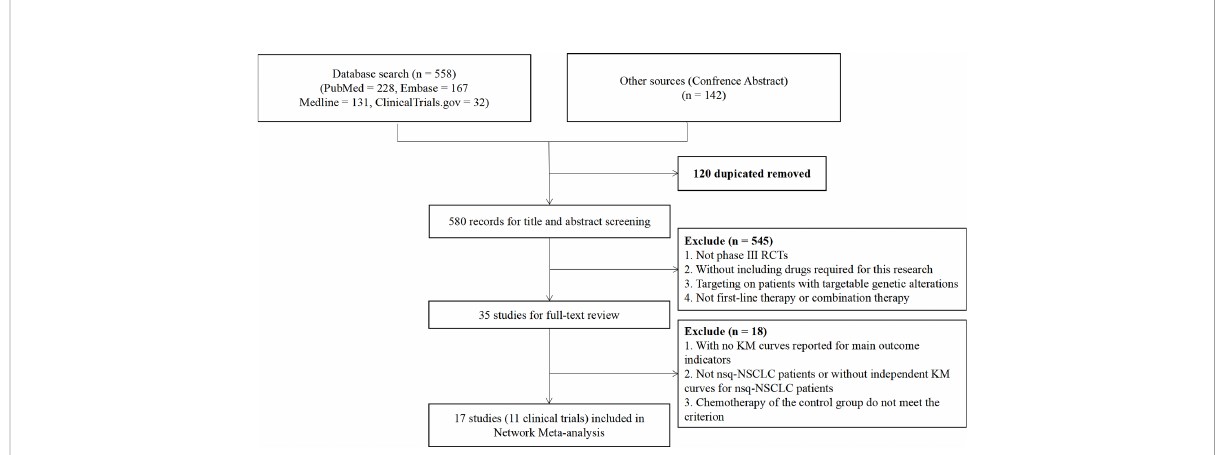
FIGURE 1 Preferred Reporting Items for Systematic Reviews and Meta-Analyses (PRISMA) fl ow diagram showing the process of literature searching and selection. The process followed the PRISMA